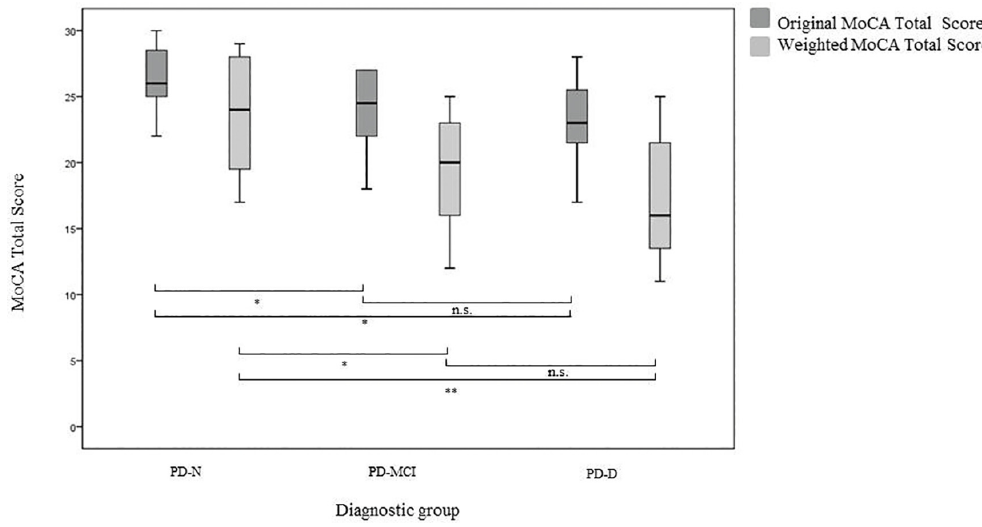
Fig 3. MoCA original and weighted scores by diagnostic group in study